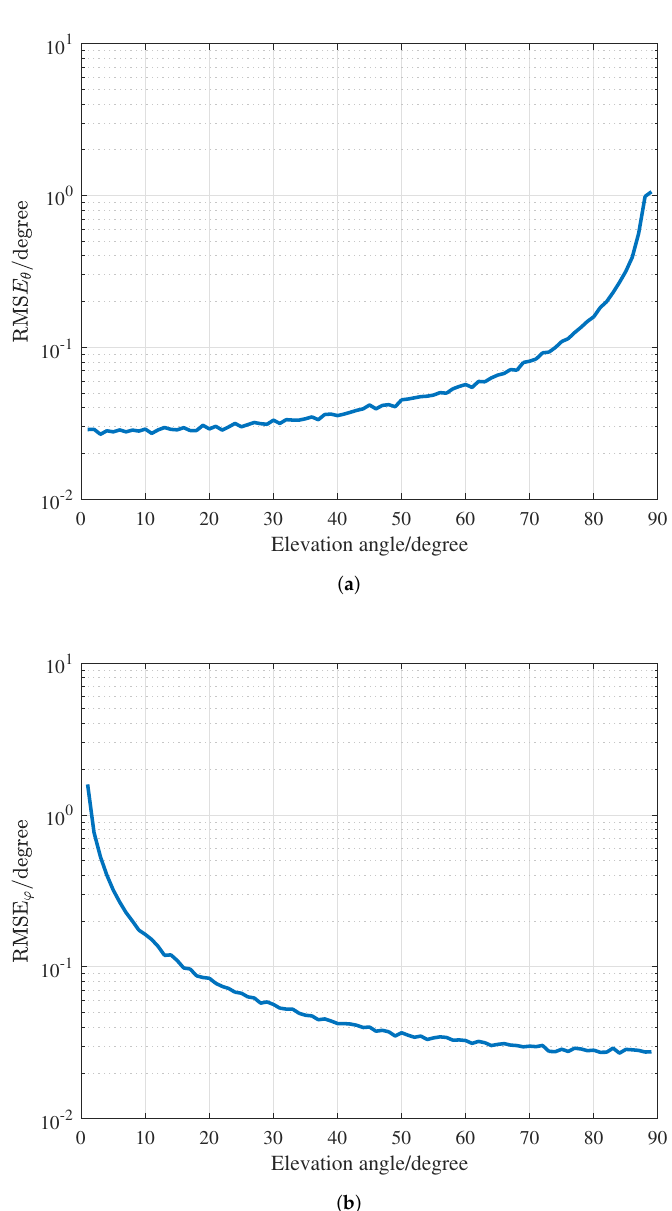
Figure 6 indicates the effect of the elevation angle variation on the performance of the proposed algorithm, where the azimuth angle is 45 ◦ and the elevation angle of the source varies from 1 ◦ to 89 ◦ . It can be clearly found from Figure 6a that the estimation performance of the elevation angle becomes worse as the elevation angle of the source increases, since the resolution of the SSCA structure decreases when the direction of the source is close to the plane of the antenna array. In Figure 6b, on the contrary, the estimation performance of the azimuth angle of the source is opposite to that of the elevation angle. In other words, as the elevation angle of the source increases, the estimation performance of the azimuth angle is improved. This is because the equivalent aperture of the CA structure is augmented in the azimuthal direction when the direction of the source is close to the plane of the antenna array.